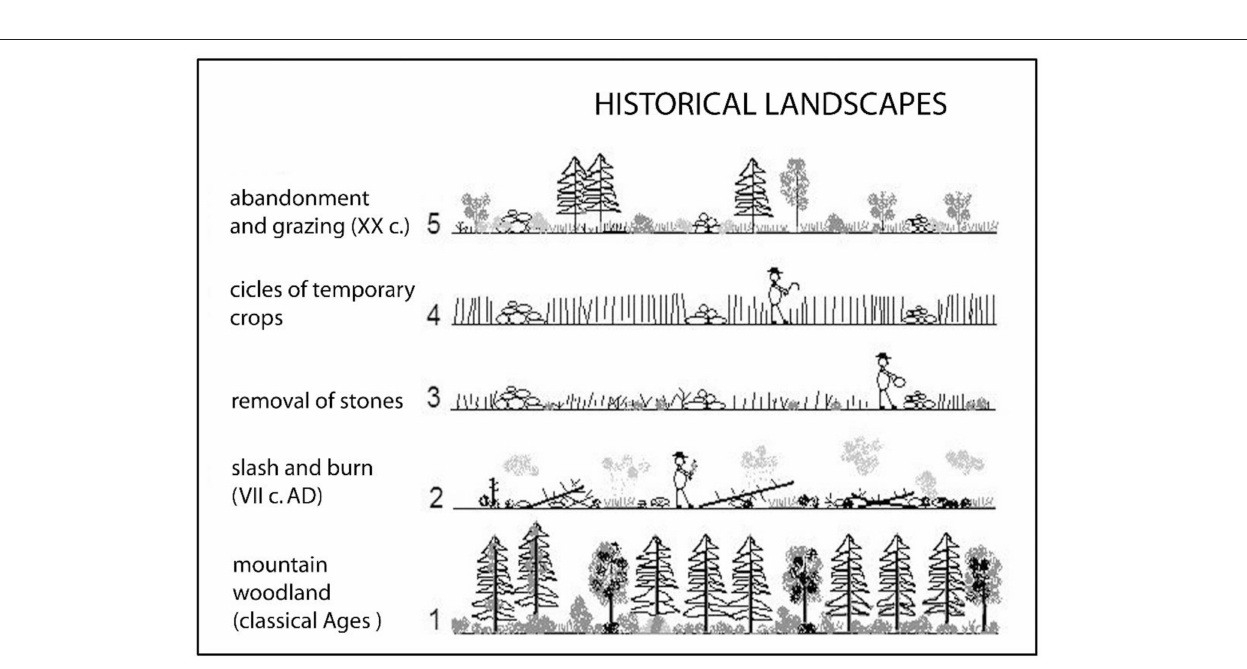
FIGURE 7 | The reconstruction of a “ronco” in “Pian delle Gròppere” in a sketch by J.P. Métailié, September 2000 in Moreno and Montanari (2008).